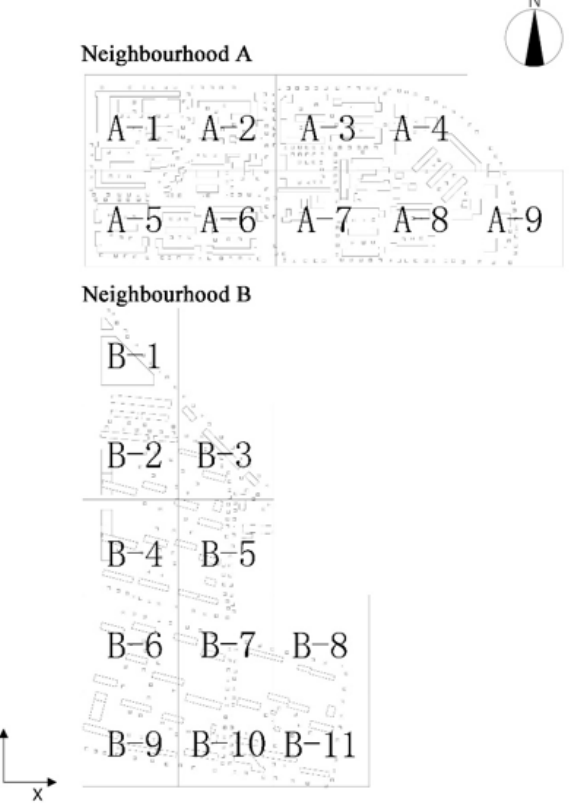
Figure 5. Grid division of neighborhoods.